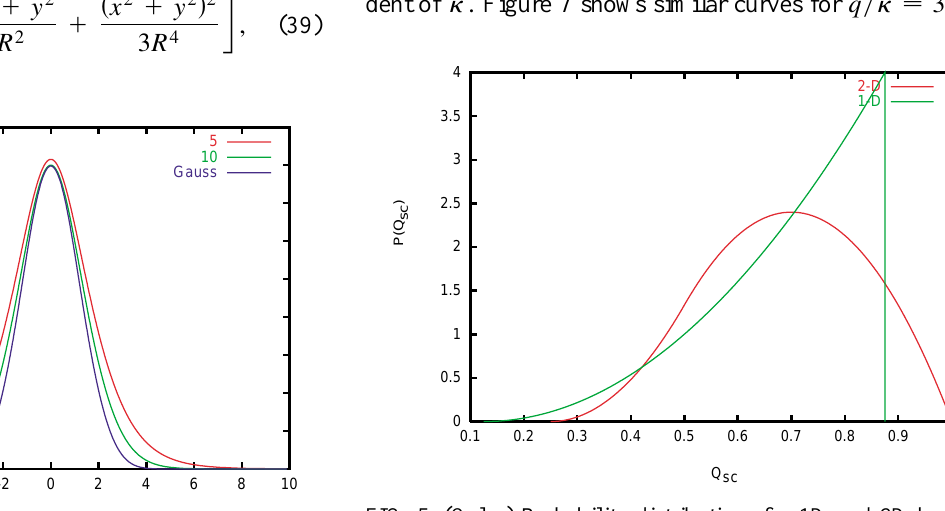
FIG. 5. (Color) Probability distributions for 1D and 2D beams with the same average and standard deviation. The peak value of the tune shift for the 2D beam is 1 while the 1D beam has k (cid:1) 5 (cid:6) 4 and q (cid:1) 3 (cid:6) 4 .